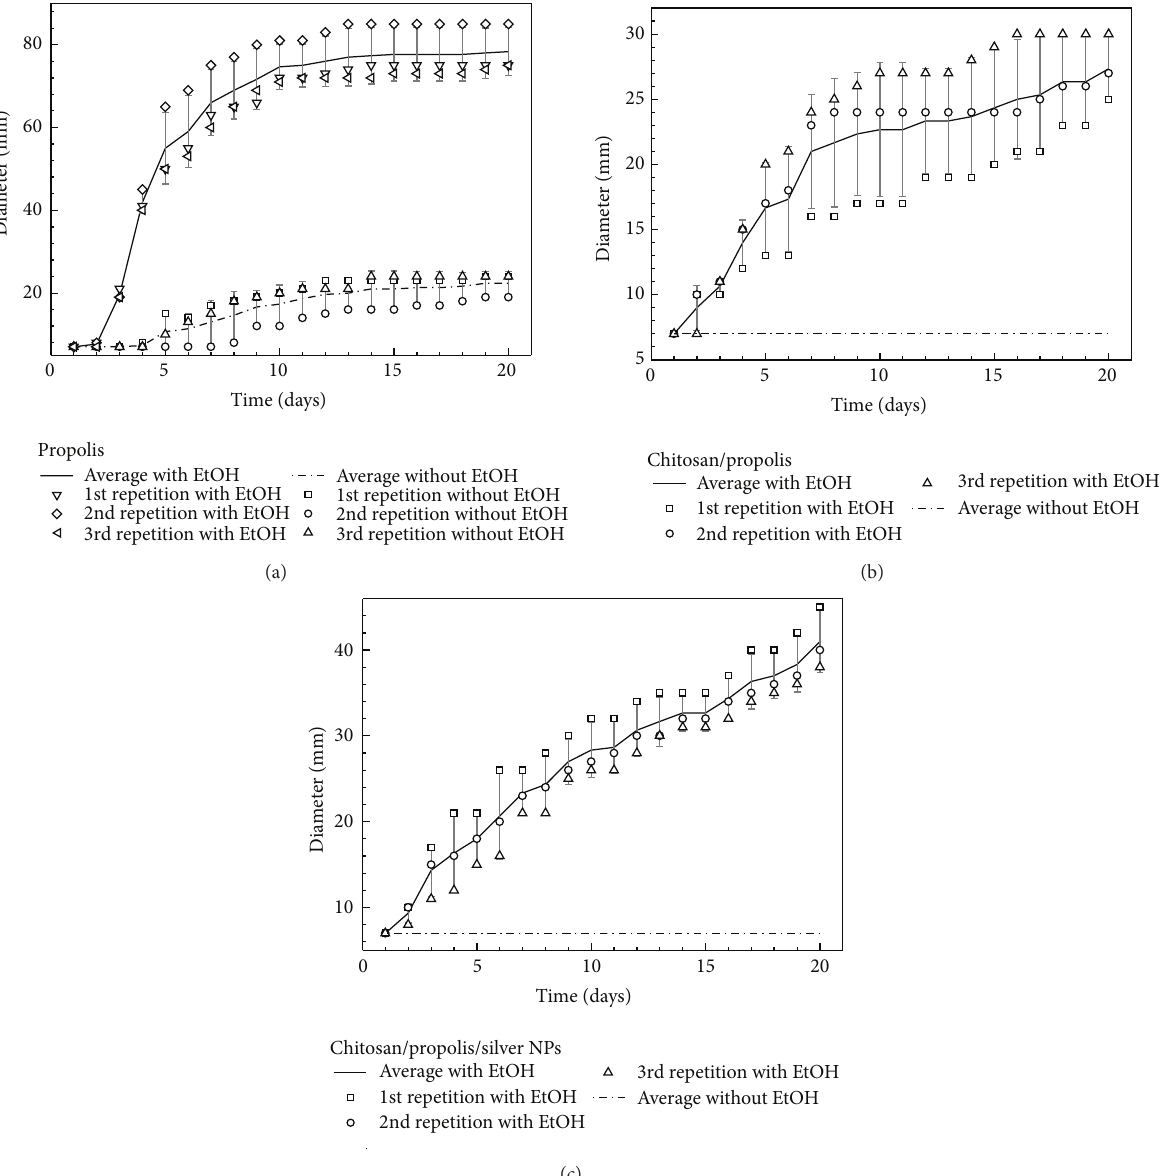
Figure 6: Antifungal action of the aqueous and hydroalcoholic media for bare propolis (a), chitosan oligomers/propolis (b), and chitosan oligomers/propolis/silver NPs (c)